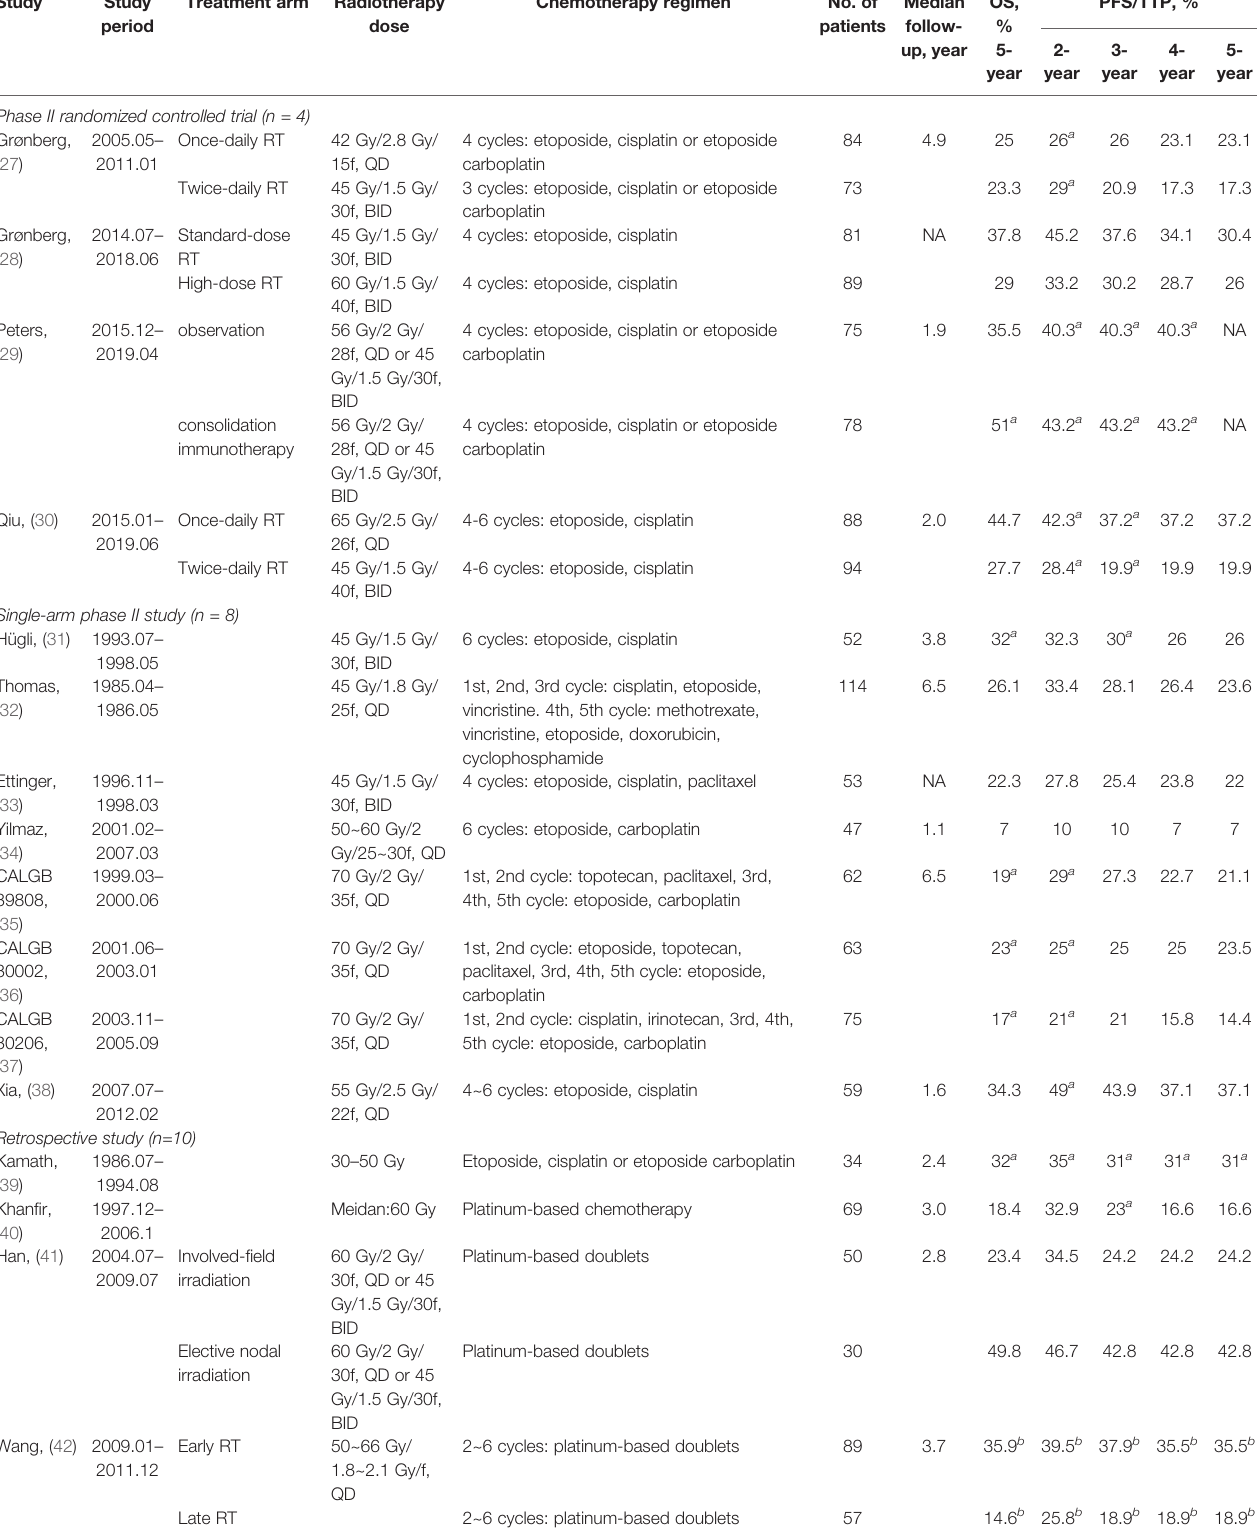
TABLE 2 | Summary of 22 phase II and retrospective studies in the current